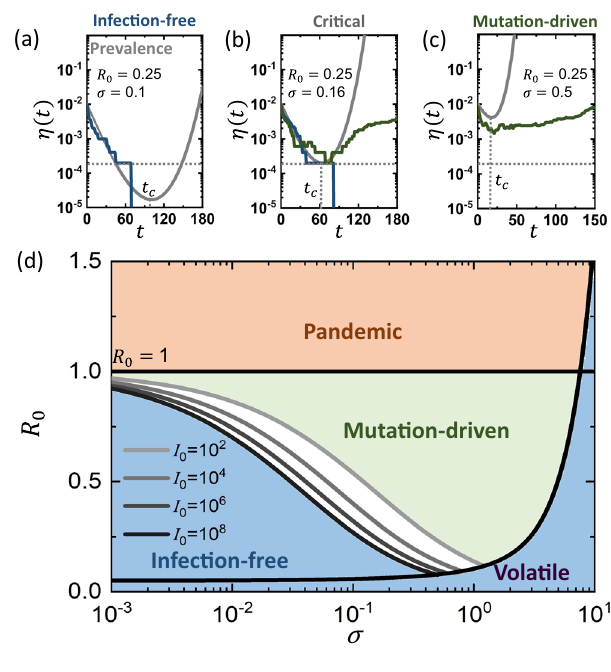
Fig. 3 | The transition to the mutation-driven phase. For mutation-driven con- tagion a critical mutation must arise before the pathogen is eliminated, namely before η ( t )crosses1/ N (horizontalgreydashedlines).Thisrepresentsthe unit-line ,a state in which a single infected individual remains among the N node population. a η ( t ) vs. t (grey solid line) as obtained from Eq. (12) in the infection-free phase ( R 0 =0.25, σ =0.1). The critical mutation occurs at the minimum point ( t c ), which is belowtheunitline.Thereforethepathogeniseliminatedpriortotheappearanceof the critical mutation. Indeed, the stochastic simulation (blue solid line) approaches zero prevalence, never reaching the exponentially growing branch of η ( t ), which arises at t > t c . b Setting σ =0.16 the system is at criticality. η ( t c ) is adjacent to the unit line, and hence we observe critical behavior: some realizations decay (blue), whereas otherssuccessfullymutate(green).Atcriticality, asthe numberof infected individuals reaches ~1, the dynamics become stochastic, and hence the outcome differs across realizations. The long term behavior of the mutation-driven branch (green) diverges from the theoretically predicted grey line, as it reaches saturation. Indeed, Eq. (12) is only designed to capture the initial stages of the spread, and disregards the exhaustion of the susceptible population that occurs at large t . c Under σ =0.5,thesystemisinthemutation-drivenphase, η ( t c )issuf fi cientlyabove the unit line and the critical mutation is reached with probability P → 1. d The phase boundary in Eq. (15) depends on the initial size of the infected population I 0 . Here weshowthisboundary for I 0 =10 2 , ... ,10 8 (grey solid lines), fi nding that thelarger is the infected population ( I 0 ), the broader is the coverage of the mutation- driven